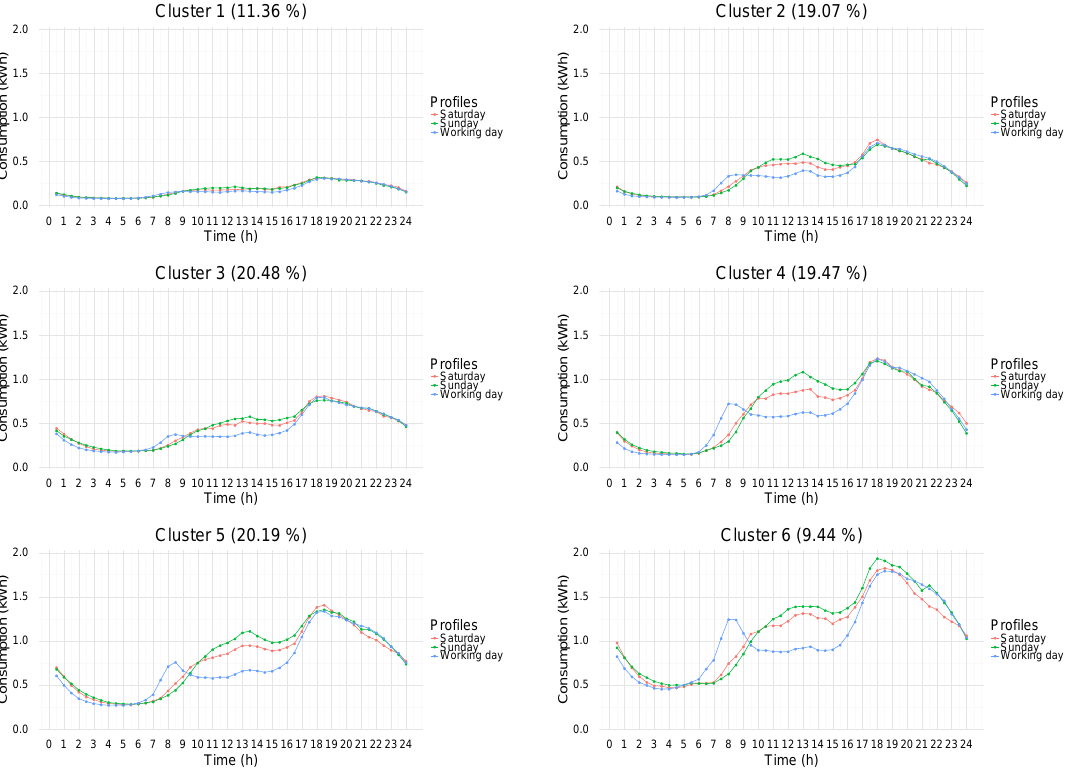
Figure 3. Electricity consumption profiles for the six clusters during Saturday, Sunday and working day for one month data